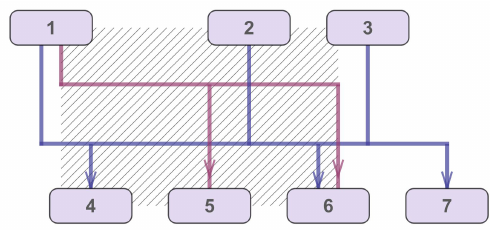
Figure 8. The area of crossings of hyperedge e 1